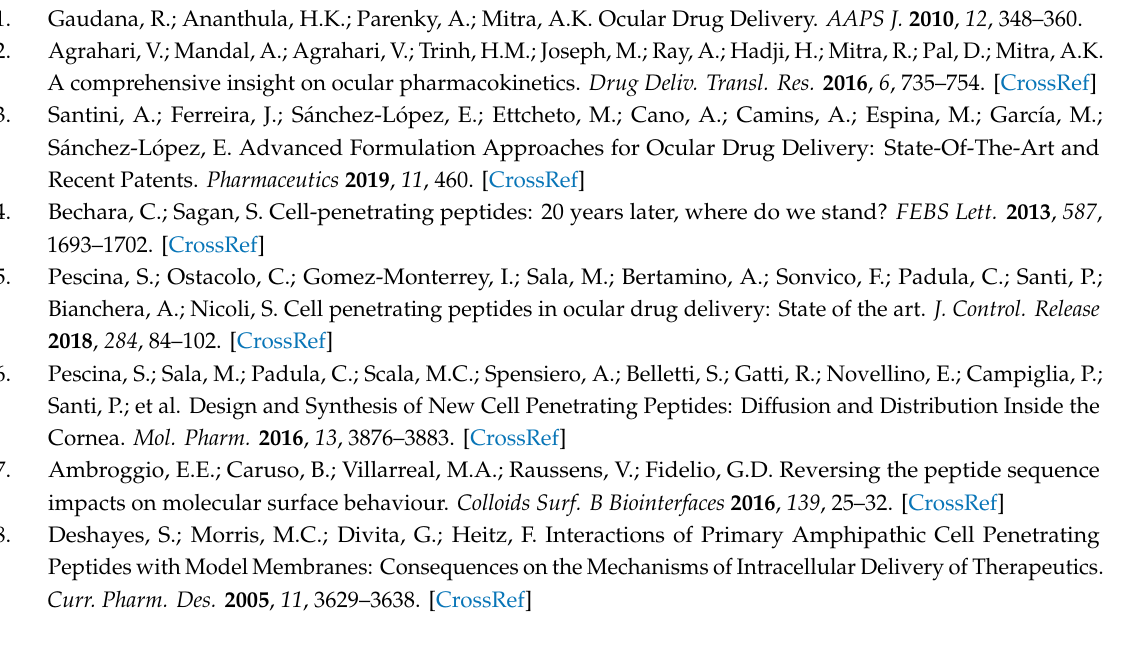
Table S1: Analytical data of synthesized peptides; Table S2: Range of calibration curves, RSD% (relative standard deviation %) and ER% (relative error %); Figures S1–S15: Mass spectrometry and HPLC of peptides used in the